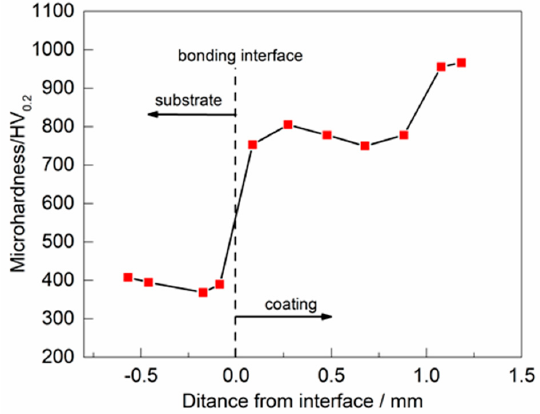
Figure 6. Cross-sectional microhardness of laser cladding specimen.